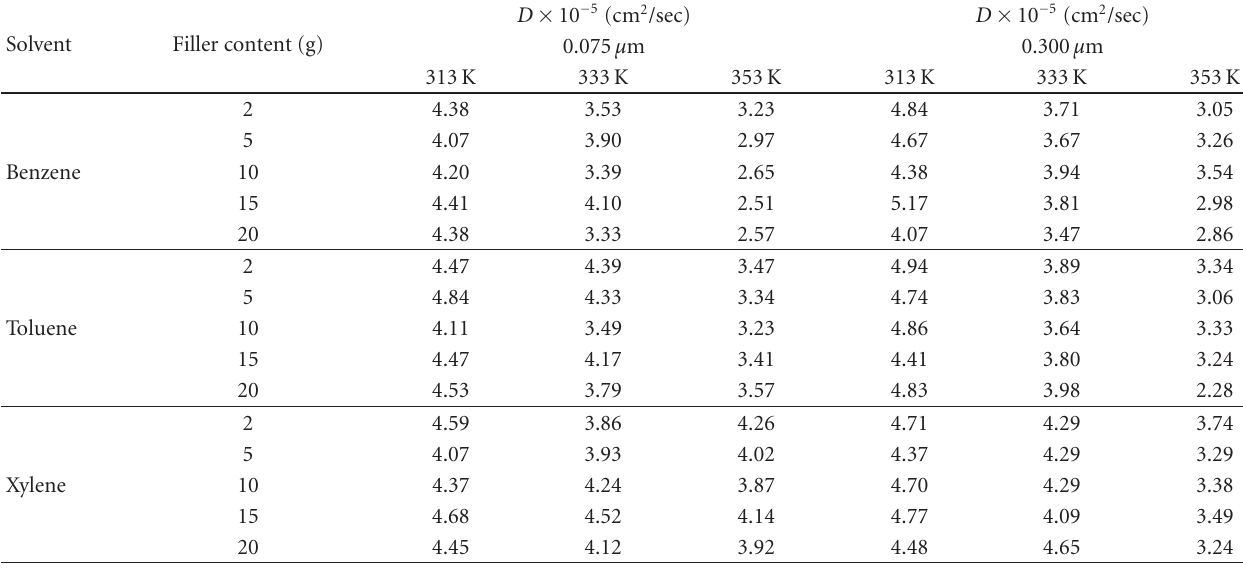
Table 2: Values of di ff usion coe ffi cients ( D ) for snail shell powder filled natural rubber at di ff erent temperatures (filler particle sizes 0.075 and 0.300 μ